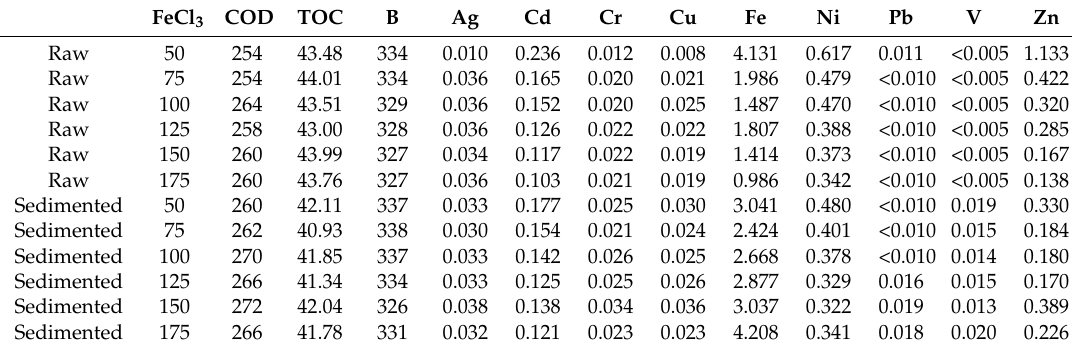
Table 2. FGD wastewater coagulation treatment results. FeCl 3 dose (mg/L), pH = 8.5, COD, TOC, B, and heavy metals (mg/L).